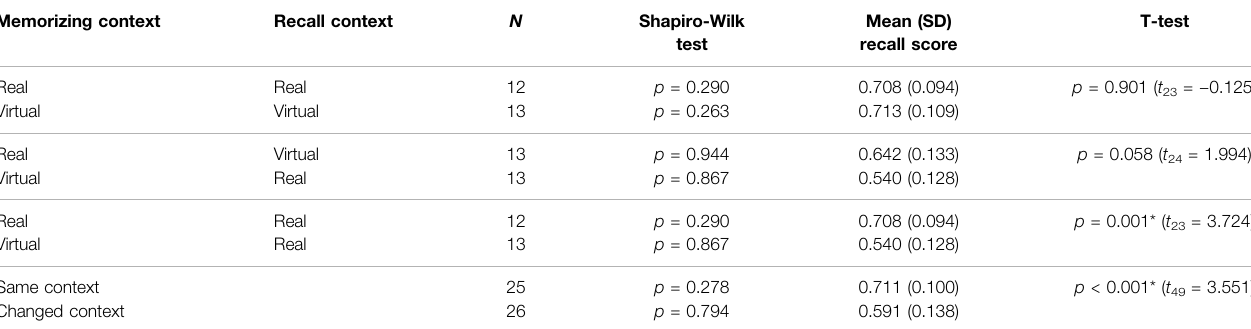
TABLE 4 | Outcomesof four independent samples Student ’ s T-tests ( p -valueswith t -statistic and degrees of freedom reported), each comparing mean recall scores of two sub-samples that are de fi ned by their memorizing and recall context